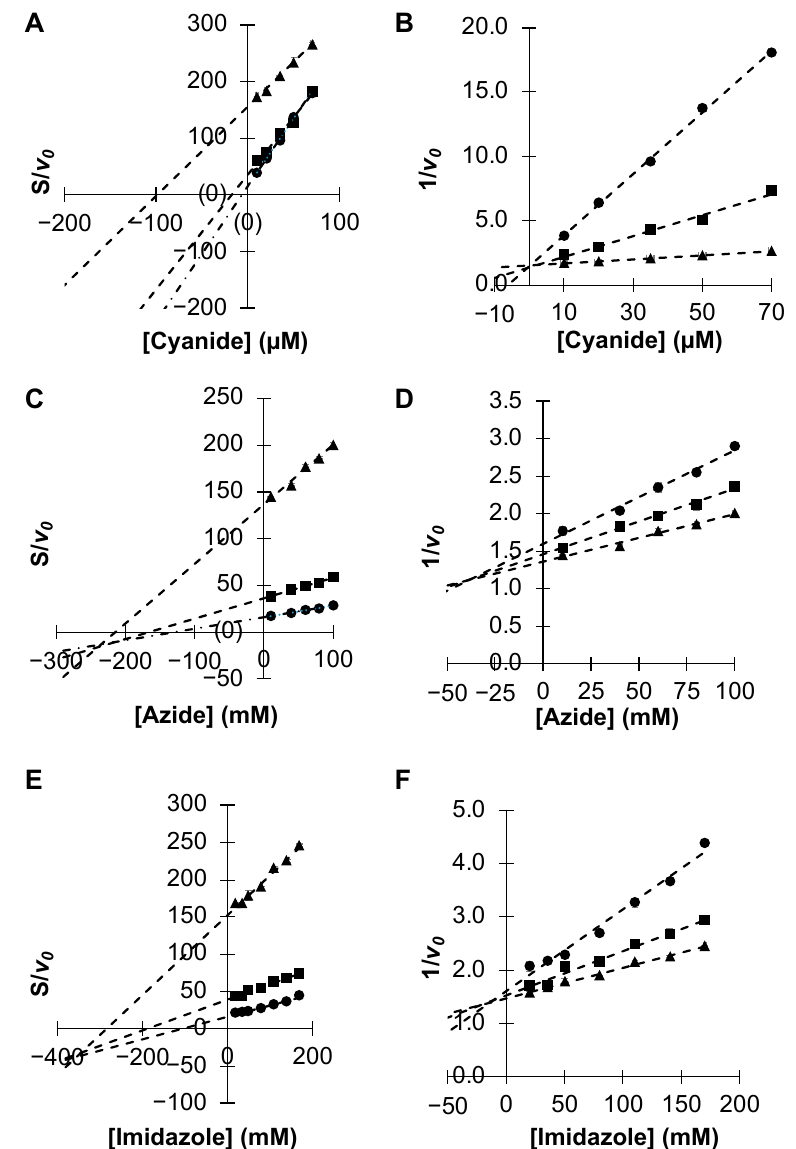
Figure 2. Determination of the inhibition constants for ( A , B ) cyanide, ( C , D ) azide, and ( E , F ) imidazole at pH 7.5. K i ’ and K i estimates are given by the intercept value in the plots of S/ v 0 (Dixon: A , C , E ) or 1/ v 0 (Cornish–Bowden: B , D , F ), respectively, against i at three different substrate concen- trations ( ● 0.1 µM, ■ 25 µM, and ▲ 100 µM H 2 O 2 ). The error bars represent the average of duplicate